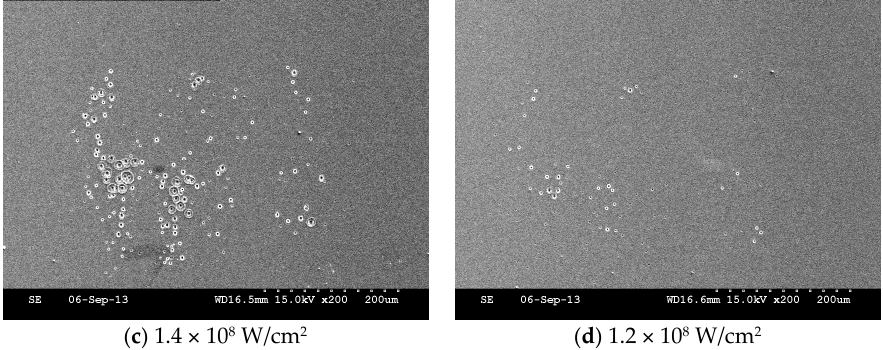
Figure 9. SEM pictures of machined holes at different laser power densities (12 ∘ C for 20 s).